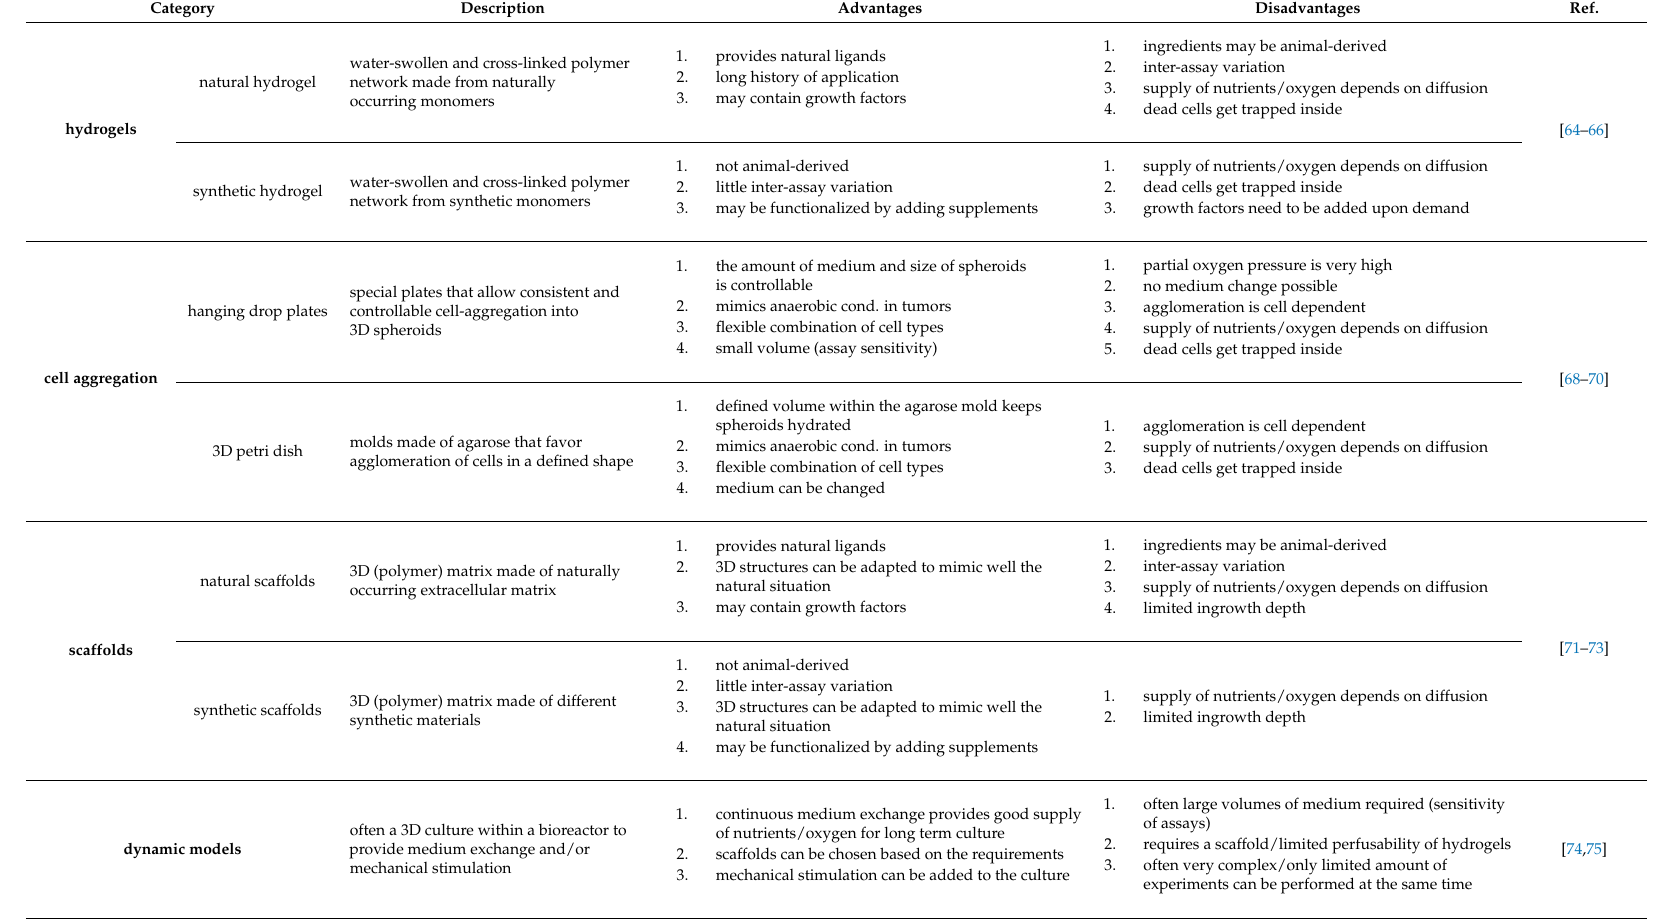
Table 2. Co-culture models in